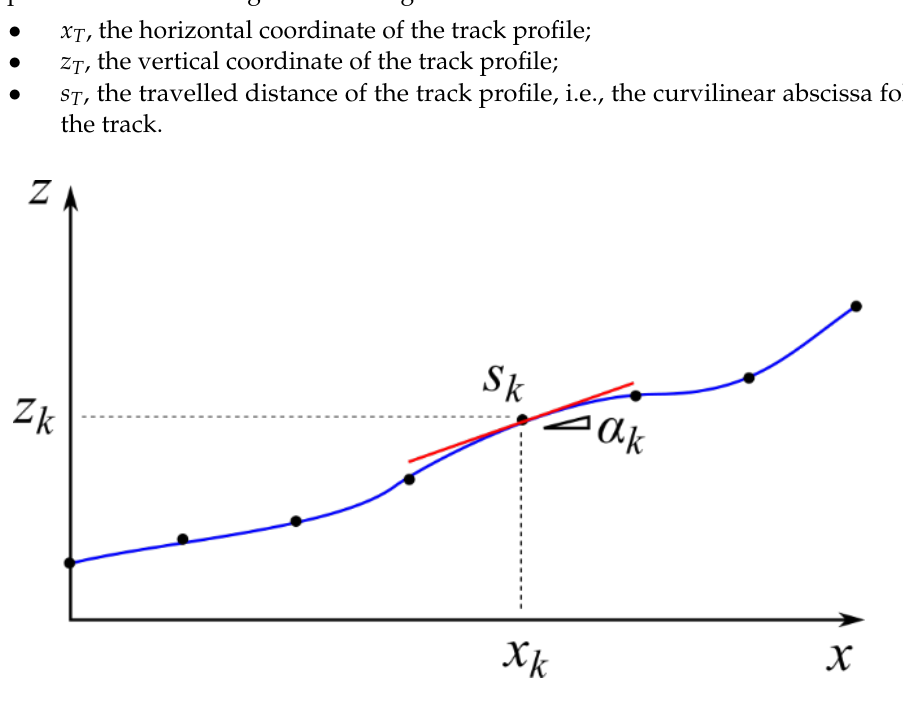
Figure 7. Track profile